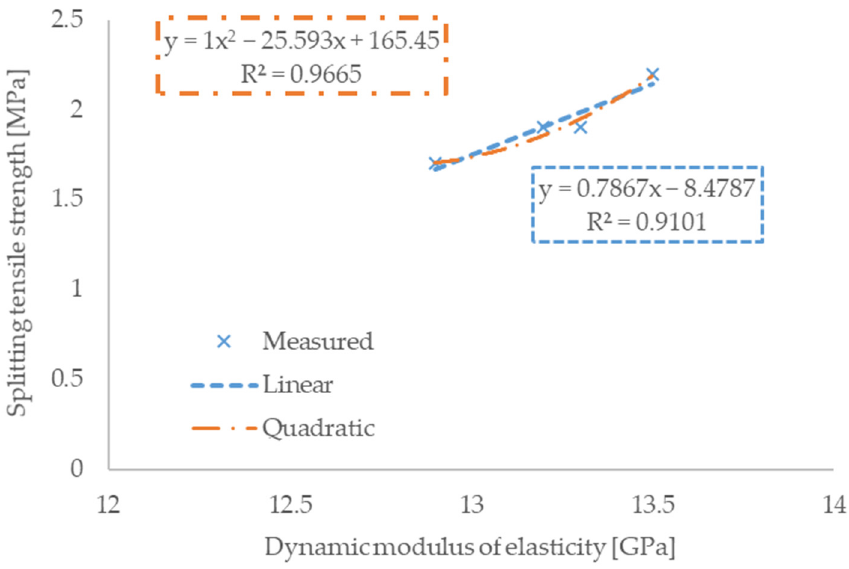
Figure 4. The relationship between dynamic modulus of elasticity and splitting tensile strength.